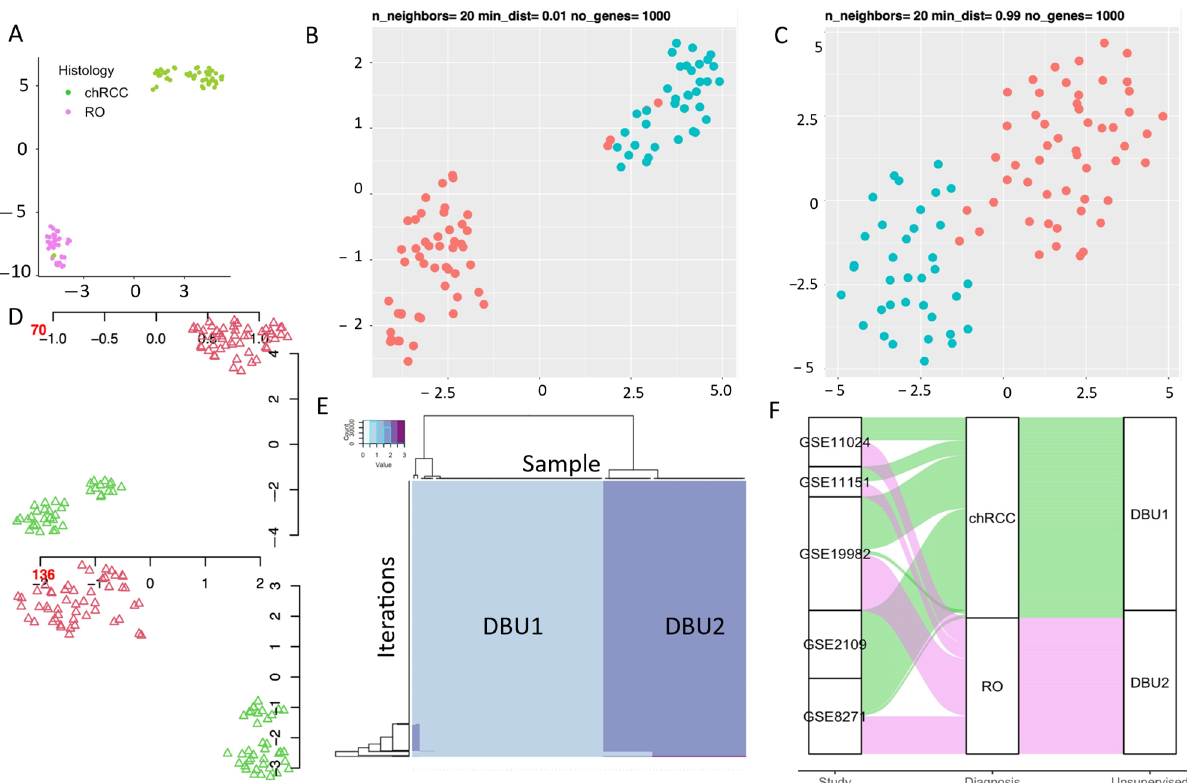
Figure 3. Implementation of unsupervised machine learning algorithm (UMLA) for differentiating chRCC and RO: ( A ) two dimension embedding for the whole genome (n = 15,875 genes) with UMAP, showing two clusters with high concordance with their histological classification; ( B ) rep- resentative map showing optimized final parameter for UMAP, best performing for maximum inter-cluster and minimum intra-cluster distance, red = chRCC, blue = RO; ( C ) representative map showing poorly fit parameters for UMAP analysis, red = “chRCC, blue = RO; ( D ) representative iterations for DBU (Iteration no 70, & 136). All 1000 iterations were tracked to determine final groups where support from > 70% iterations were needed, red triangles = cluster 1 in machine learning model, green triangles = cluster 2 in machine learning model ( E ) group consensus heatmap. Samples are presented in columns and iterations are in rows. Two colors (dark and light blue) represent two DBU groups based on the 1000 iterations of DBU with 1000 random genes in each iteration; ( F ) Sankey’s diagram tracking all samples from the study to DBU classification, color represents histol- ogy type (ChRCC = green, RO = pink). A total of 87/89 samples follow their histological classification with DBU.